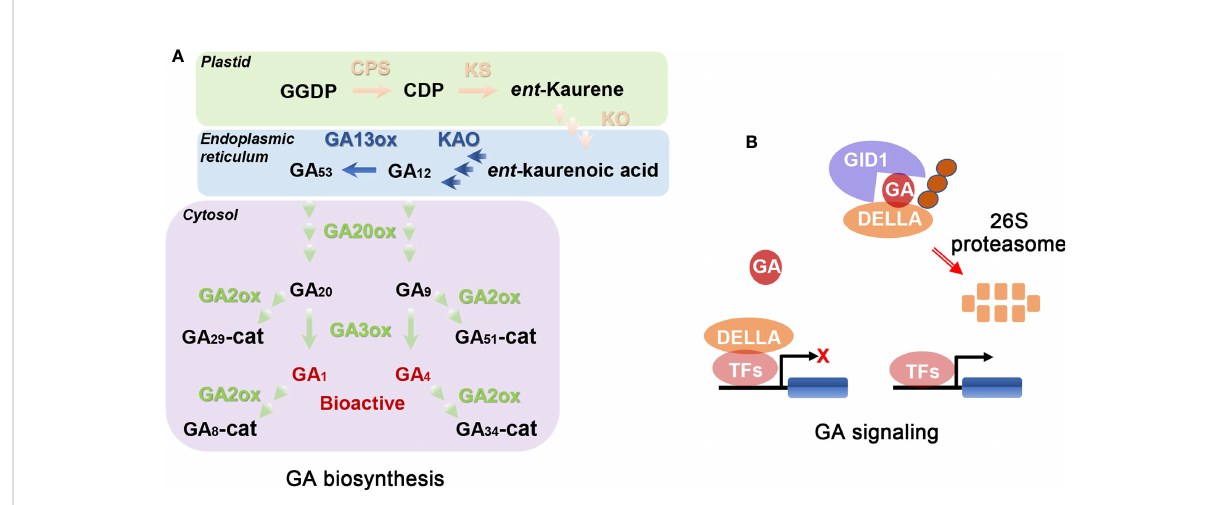
FIGURE 1 Schematic representations of GA biosynthesis (A) and signal (B) pathways (Yamaguchi, 2008; Binenbaum et al., 2018; Wu et al., 2020). (A) GGDP, CDP, and cat represent geranylgeranyl diphosphate, ent -copalyl diphosphate, and catabolite, respectively. CPS, KS, KO, and KAO represent ent - copalyl diphosphate synthase, ent -kaurene synthase, ent -kaurene oxidase, and ent -kaurenoic acid oxidase, respectively. GA13ox, GA20ox, GA3ox, and GA2ox represent GA13-oxidases, GA20-oxidases, GA3-oxidases, and GA2-oxidases, respectively. CPS, KS, KO, KAO, GA13ox, GA20ox, and GA3ox are the key enzymes in GA biosynthetic pathway. GA2ox is GA deactivated enzyme. Enzymes locate in plastid, endoplasmic reticulum, and cytosol using pink font, green font, and blue font, respectively. Bioactive metabolic products (GA 1 and GA 4 ) use red font. The remaining metabolic products use black font. (B) When bioactive GAs are exhausted or limited, DELLAs (consisting of the following proteins: GA-INSENSITIVE, GAI; REPRESSOR OF GA1-3, RGA; RGA-LIKE1, RGL1; RGL2 and RGL3; GRAS-domain proteins) interact with transcription factors (TFs) inhibiting expression of corresponding downstream genes and therefore growth. When endogenous GA concentration is increased, a complex of GA- INSENSITIVE DWARF1 (GID1; the GA receptor)-GA-DELLA is formed. Then, the complex is recognized by the F-box proteins, leading to degradation of DELLA by ubiquitin-26S proteasome system and thus releasing the growth inhibition. GID1 and DELLAs are the core components of GA signal pathway. The orange circles represent F-box proteins, such as SLEEPY1